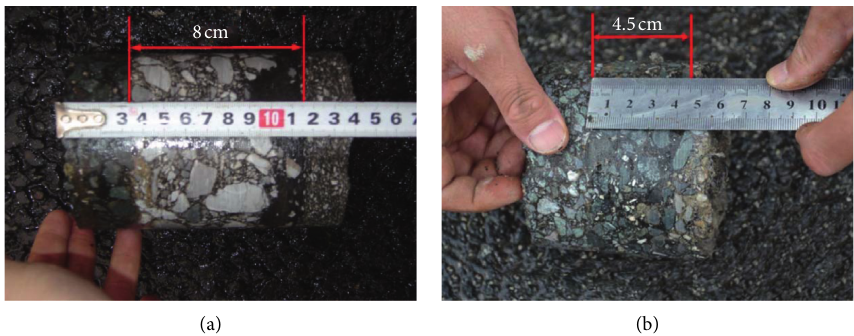
Figure 12: Core sample test of asphalt overlay: (a) after one month; (b) after three